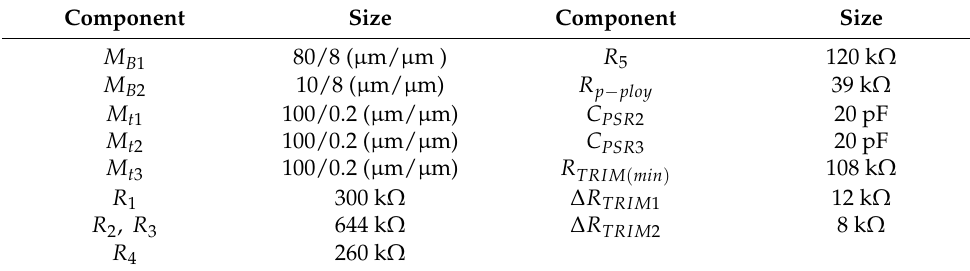
Table 1. Sizes of the Components in Voltage Reference Circuit.